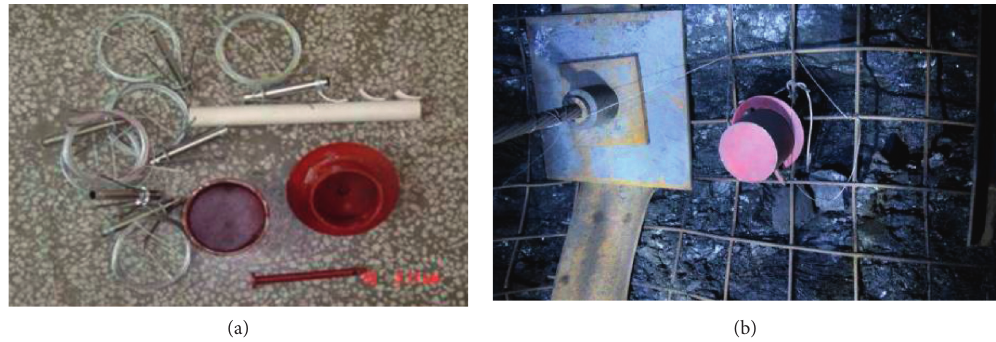
Figure 7: KDW-1 displacement meter at the rib: (a) displacement meter; (b) installation at the rib.